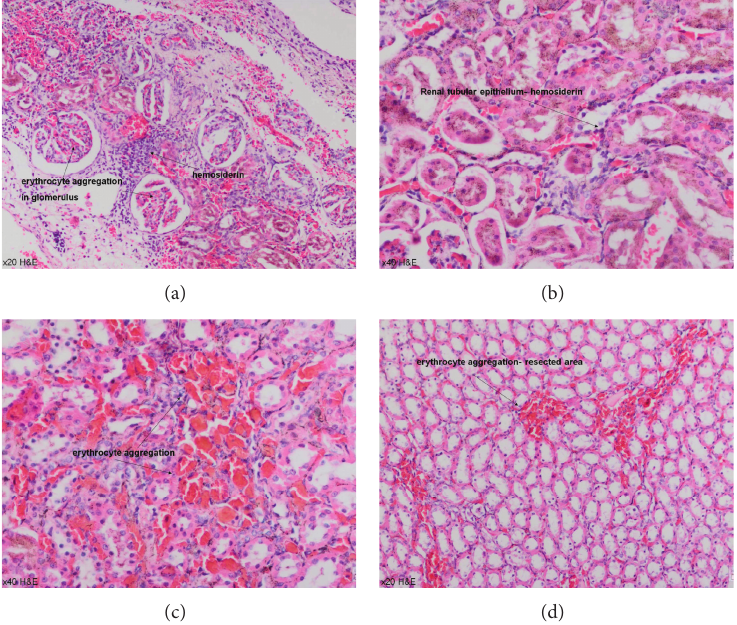
Figure 7: Erythrocyte aggregation in glomerular field and interstitium in ABS Nanohemostat group (20–40xHE).